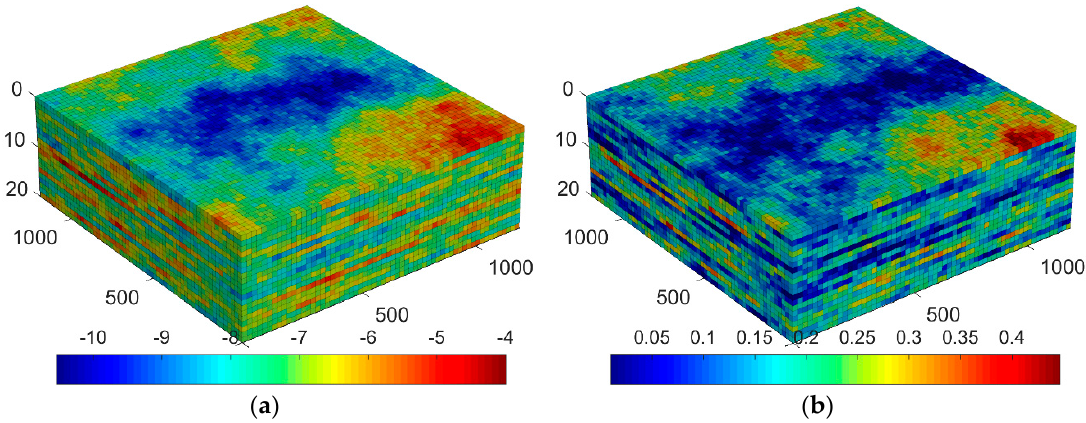
Figure 12. Distributions of ( a ) the hydraulic conductivity in Log 10 scale and ( b ) the effective porosity for the three-dimensional heterogeneous aquifer. The geological model comprises 20 layers with 1m resolution along the vertical direction.